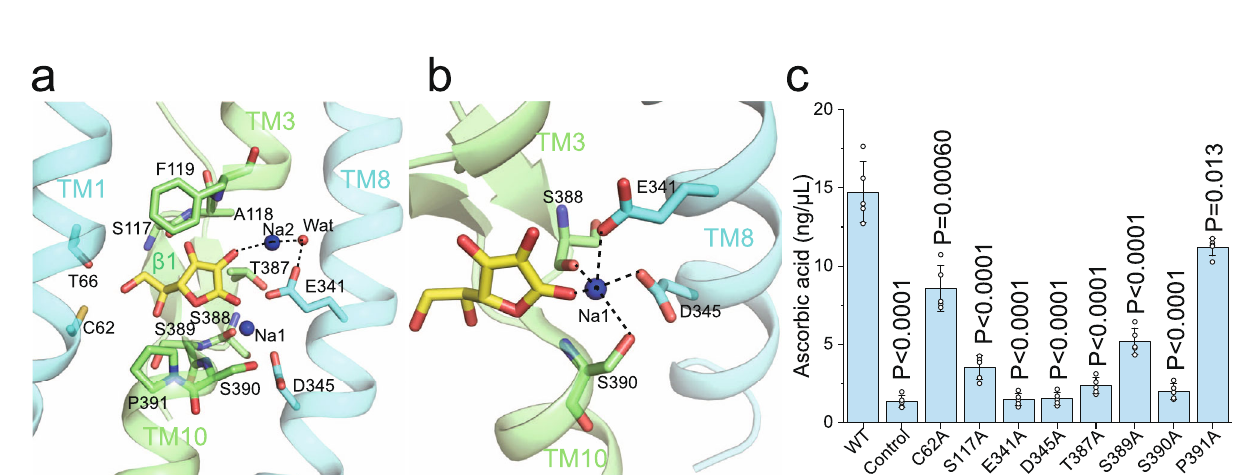
Fig. 2 | Extracellular interfaces ofMmSVCT1. a One subunitof MmSVCT1 viewed from the gate domain with a zoomed-in view of interface I. The TM13 helix was removed for clarity.The centralporecalculatedby the program Hole isshown asa dotted mesh. b Magni fi ed view of interface II. c Transport activity of MmSVCT1